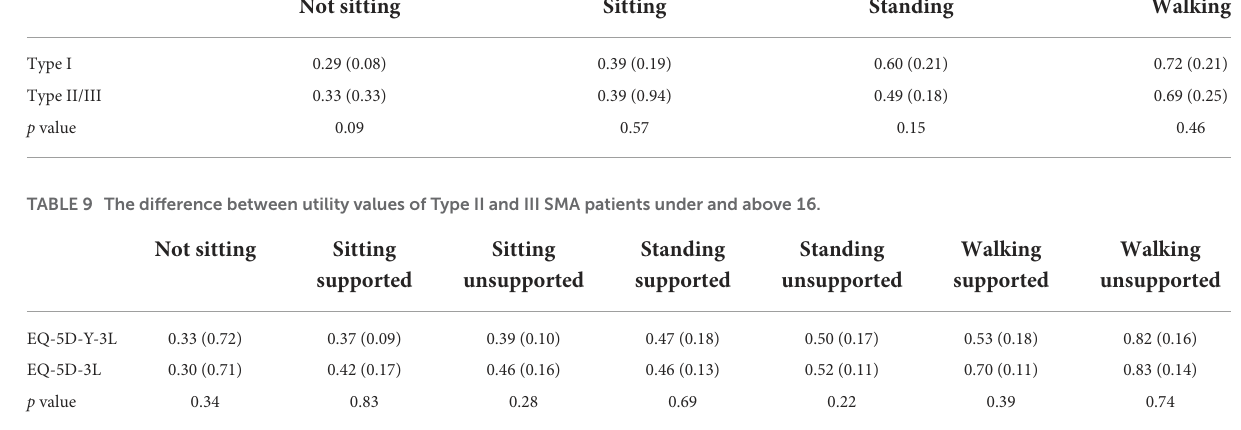
TABLE 8 The difference between utility values of Type I, Type II and III SMA patients. Not sitting Sitting Standing Walking